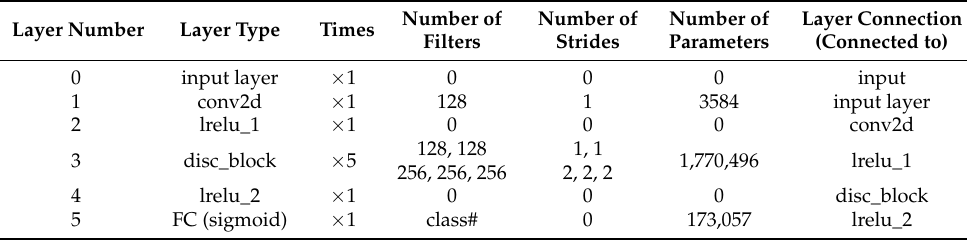
Table 6. Description of the discriminator network of PI-GAN.